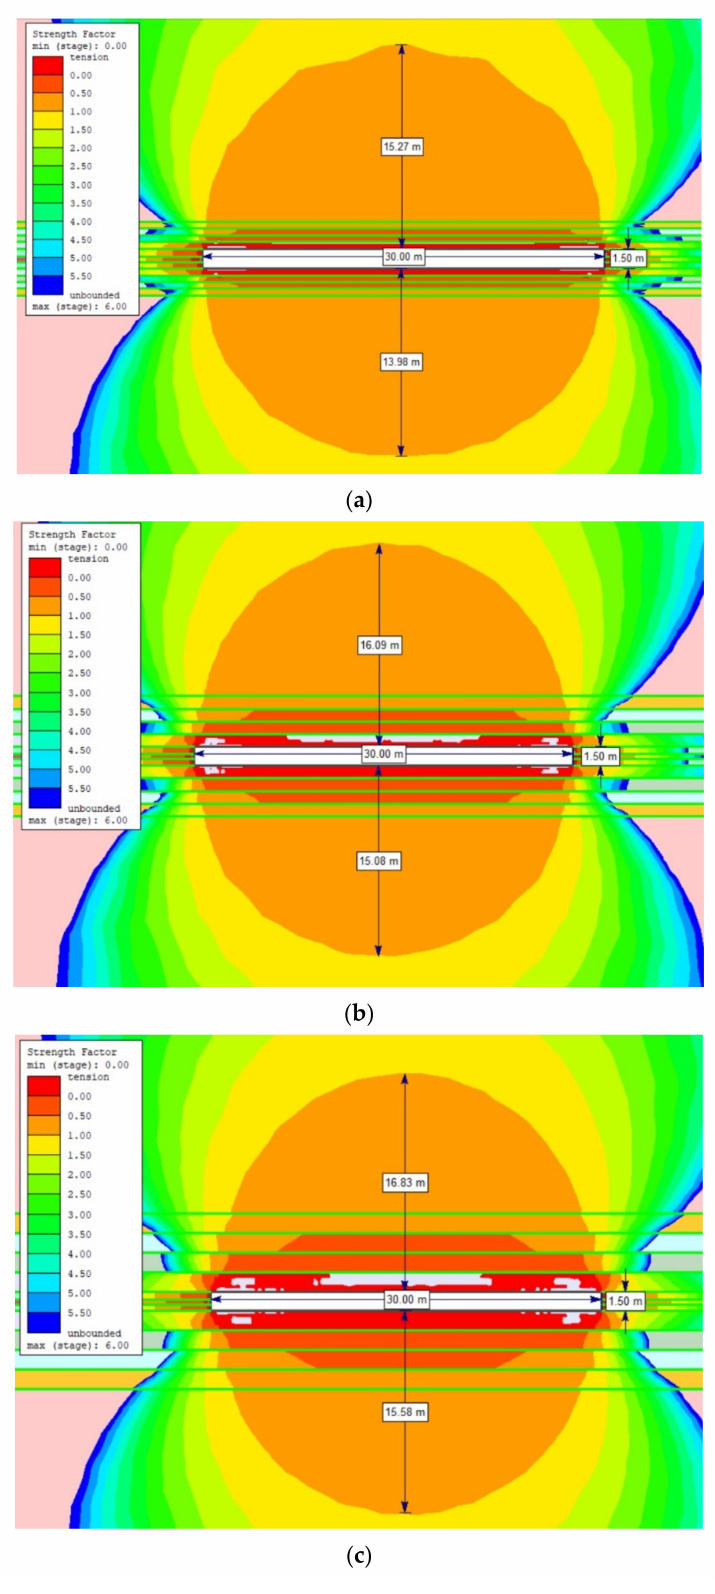
Figure 17. The extent of the rock destruction zone around the gasification channel with a width of 30 m and the impact of temperature of 1200 ◦ C for the wet rock mass, up to the height of: ( a ) 0.5 m; ( b ) 1.0 m; ( c ) 1.5